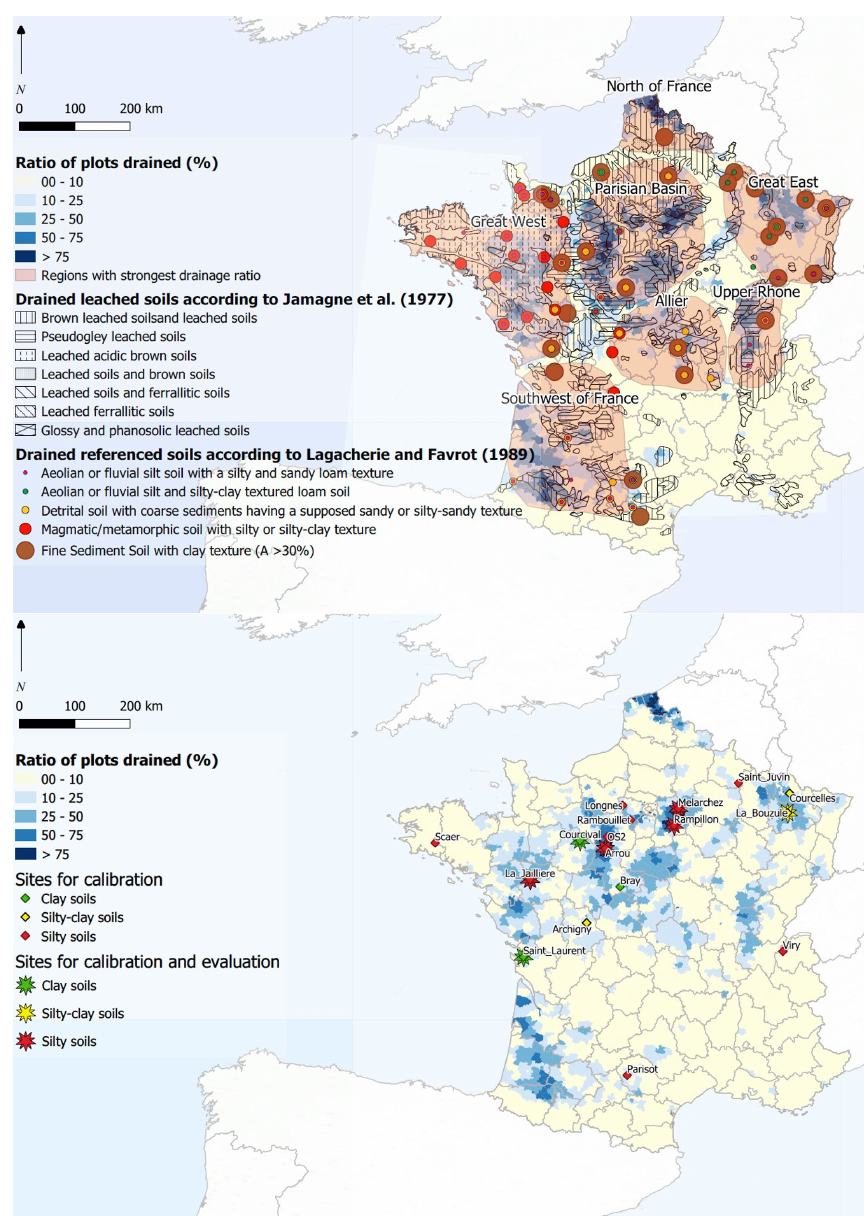
Figure 1. The pedological distribution of French soils, produced by Jamagne et al. (1977) and Lagacherie and Favrot (1989), overlain on the spatial distribution of French drainage (RGA, 2010; top panel). The spatial distribution of sites aggregated by texture with observed flow data is shown in the bottom